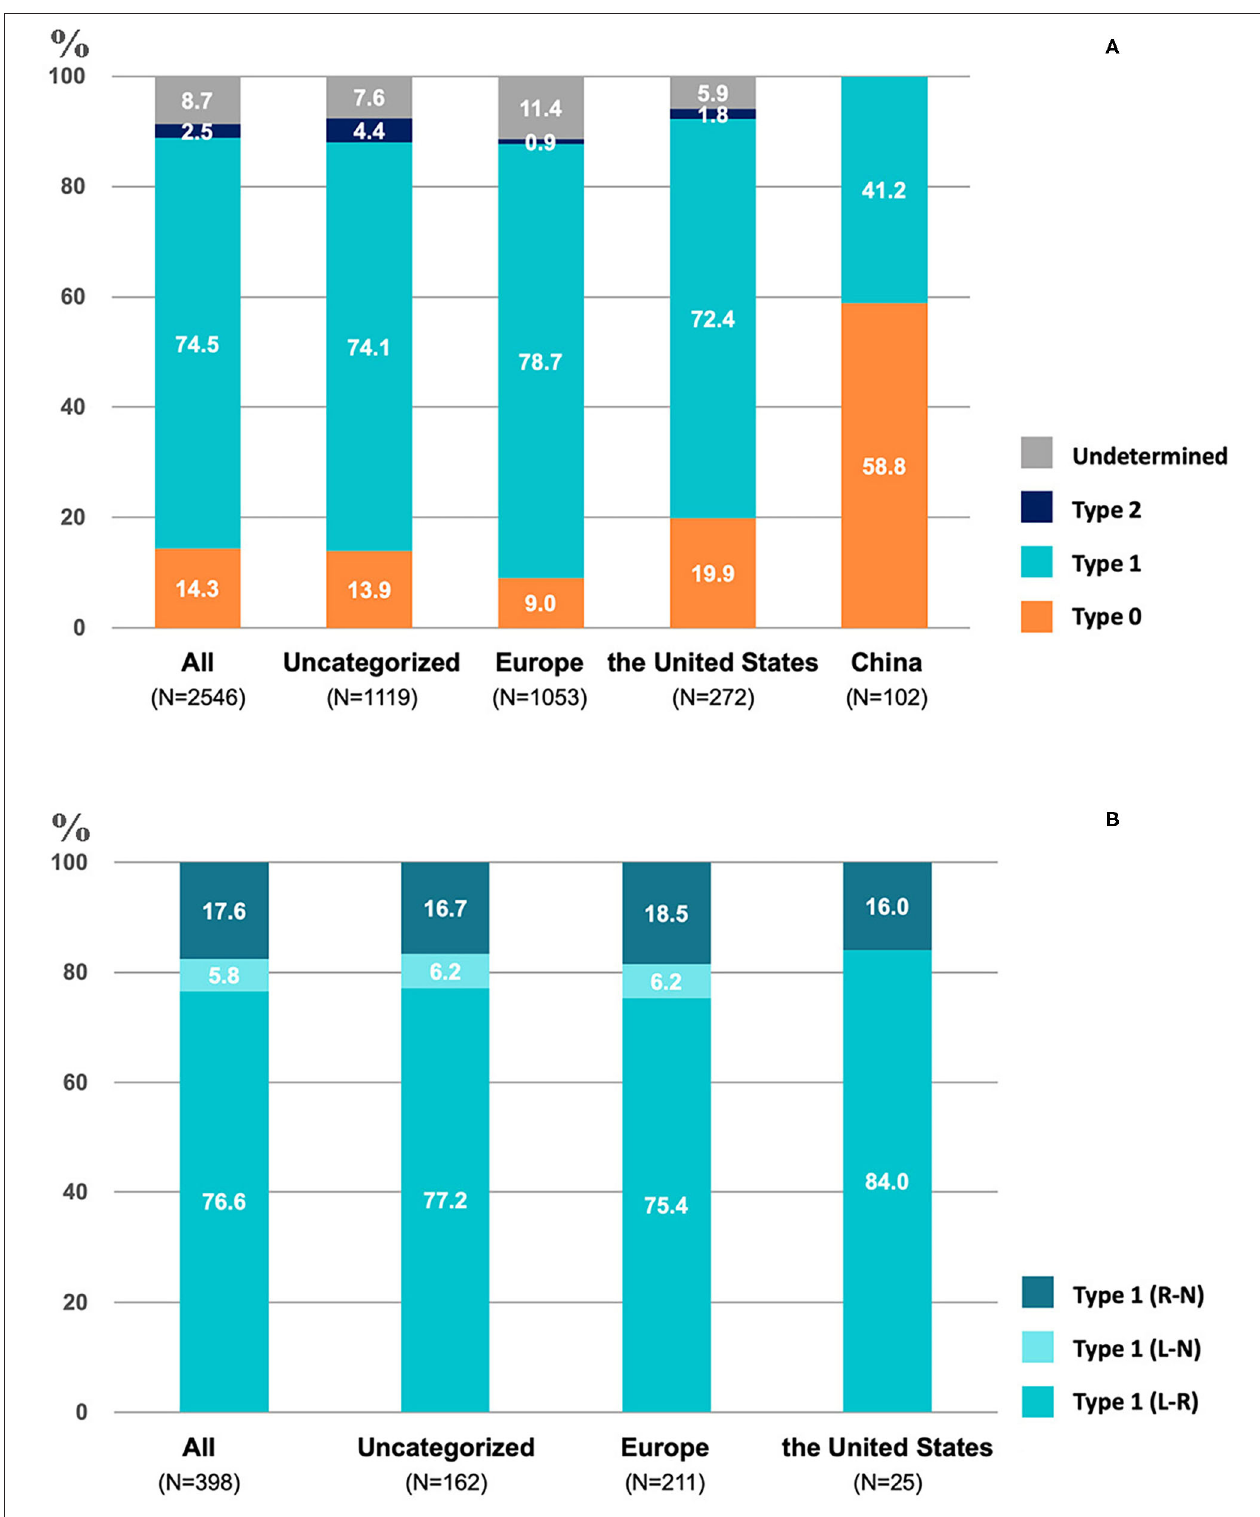
FIGURE 2 | The proportion of different valve phenotypes of bicuspid aortic valve (BAV) (A) and type-1 (B) in included studies.